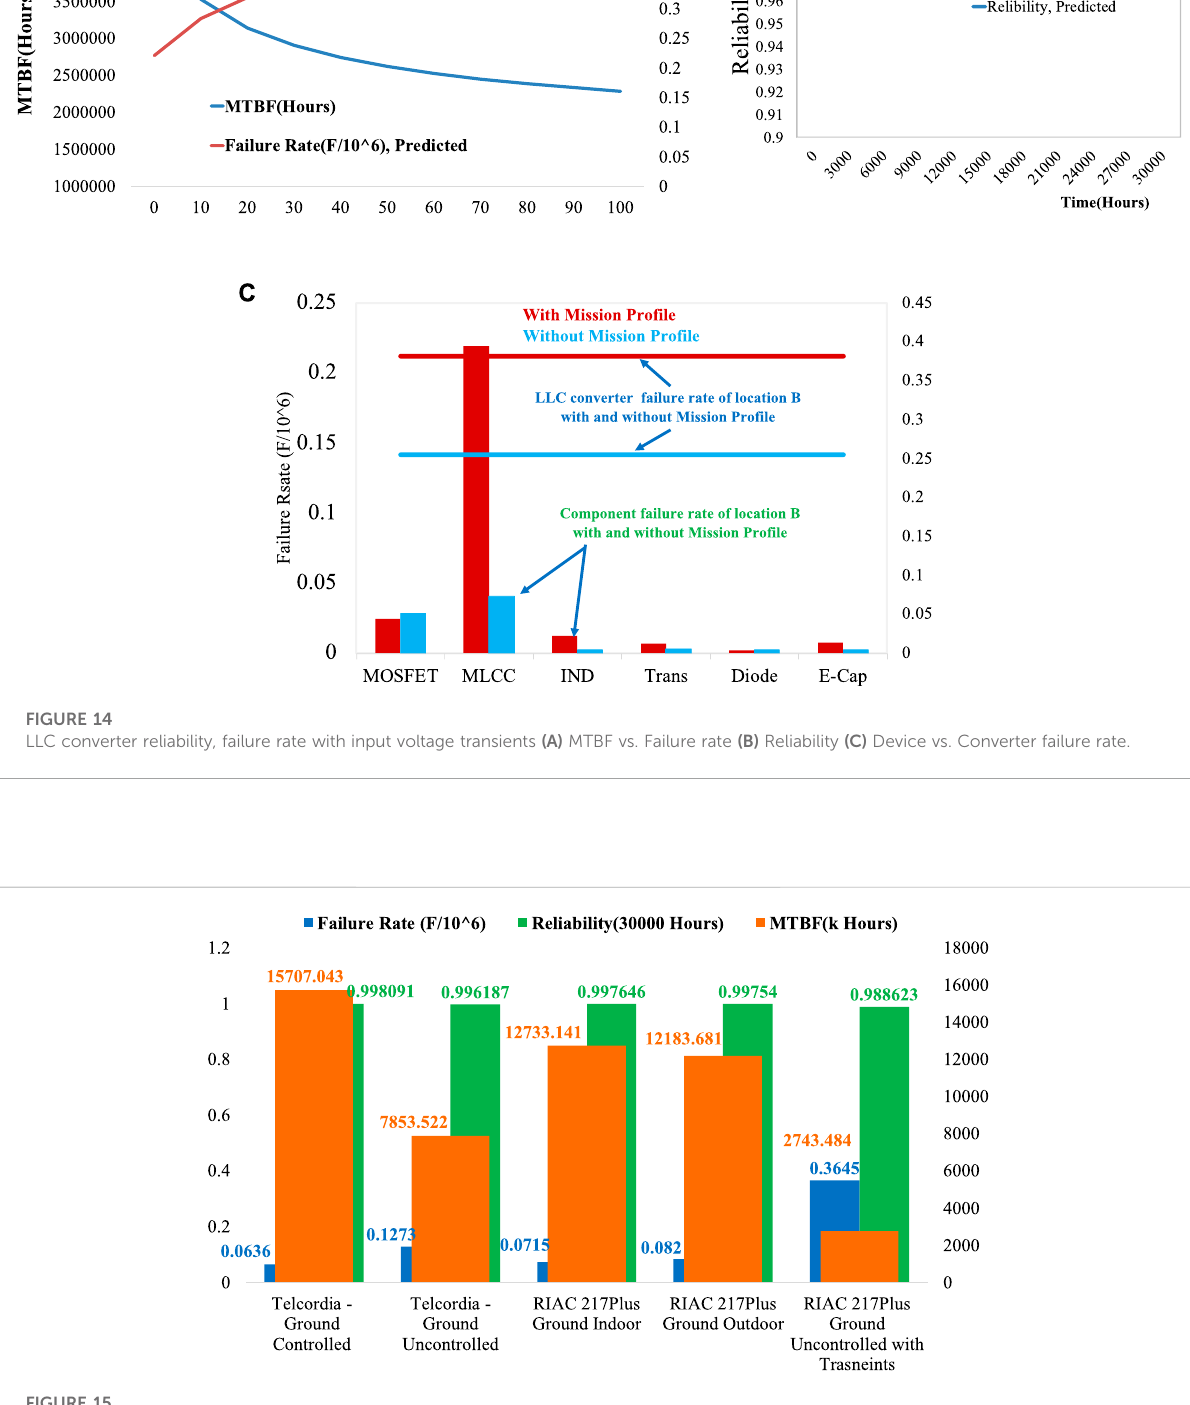
FIGURE 15 Comparison of quality and reliability